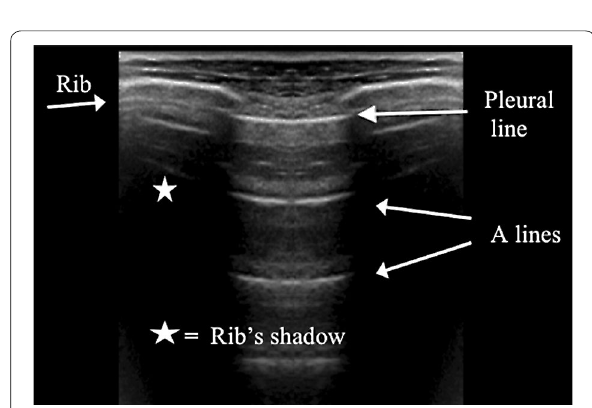
Fig. 2 A profile according to the BLUE protocol showing multiple A